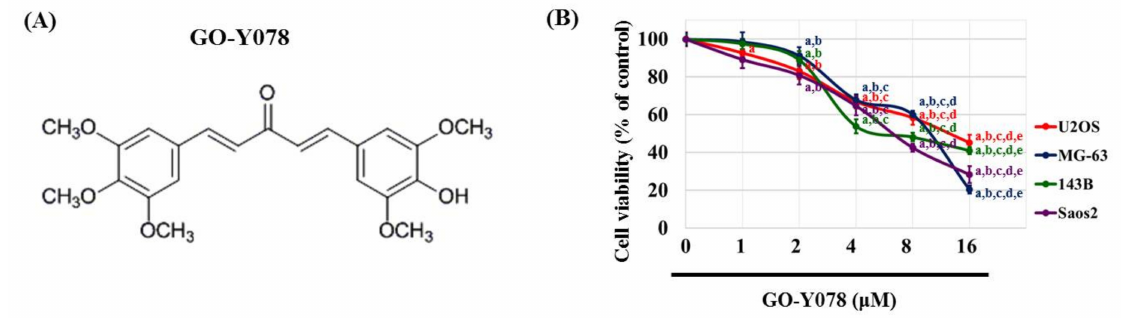
Figure 1. Effects of GO-Y078 on the cell viability of U2OS, MG-63, 143B, and Saos-2 cells. ( A ) The structure of curcumin analog GO-Y078. ( B ) The viability of U2OS, MG-63, 143B, and Saos-2 cells treated with GO-Y078 (1, 2, 4, 8, and 16 µ M) for 24 h was detected by MTT assay and the effects are illustrated after quantitative analysis. Results are shown as mean ± S.D. ANOVA analysis with Scheffe’s posteriori comparison was used. U2OS ( n ≥ 7): F = 314.386, p < 0.001; MG-63: F = 863.541, p < 0.001; 143B ( n ≥ 4): F = 453.149, p < 0.001; Saos-2 ( n ≥ 8): F = 451.896, p < 0.001. a Significantly different, p < 0.05, when compared to control. b Significantly different, p < 0.05, when compared to 1 µ M. c Significantly different, p < 0.05, when compared to 2 µ M. d Significantly different, p < 0.05, when compared to 4 µ M. e Significantly different, p < 0.05, when compared to 8 µ